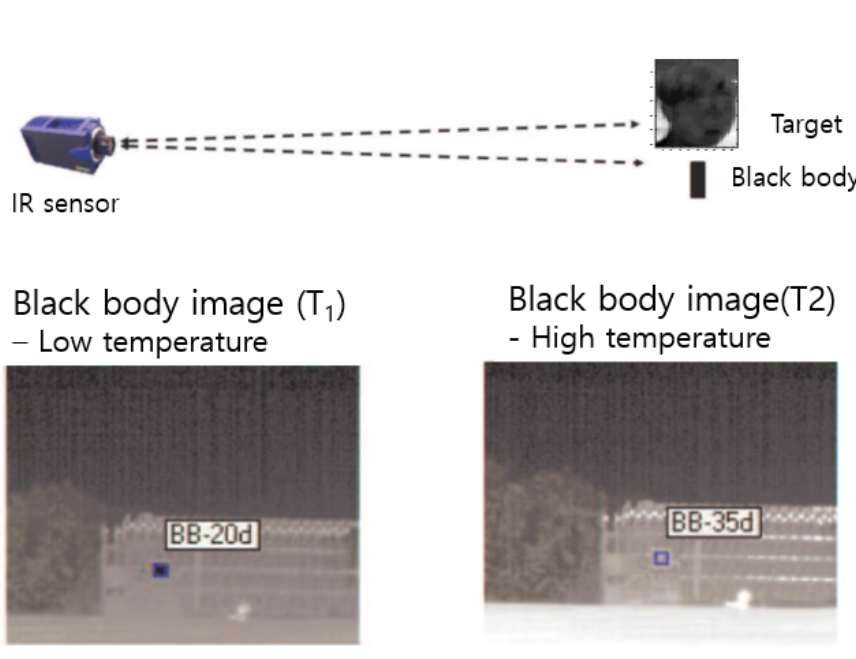
Figure 3. Remote hot/cold blackbody measure.